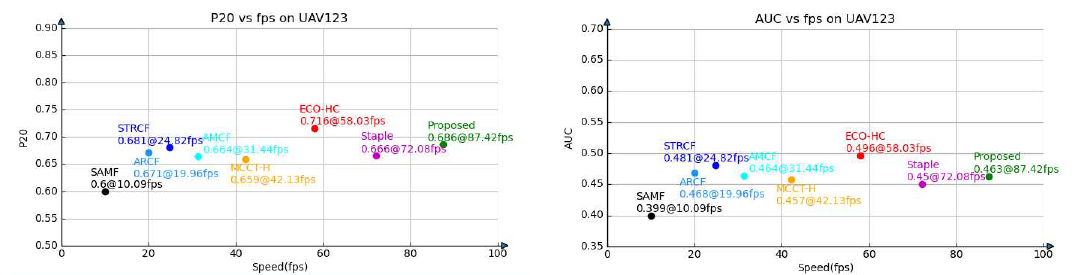
Figure 10. Performance efficiency plot on UAV123 of CRCF_ATU tracker and existing